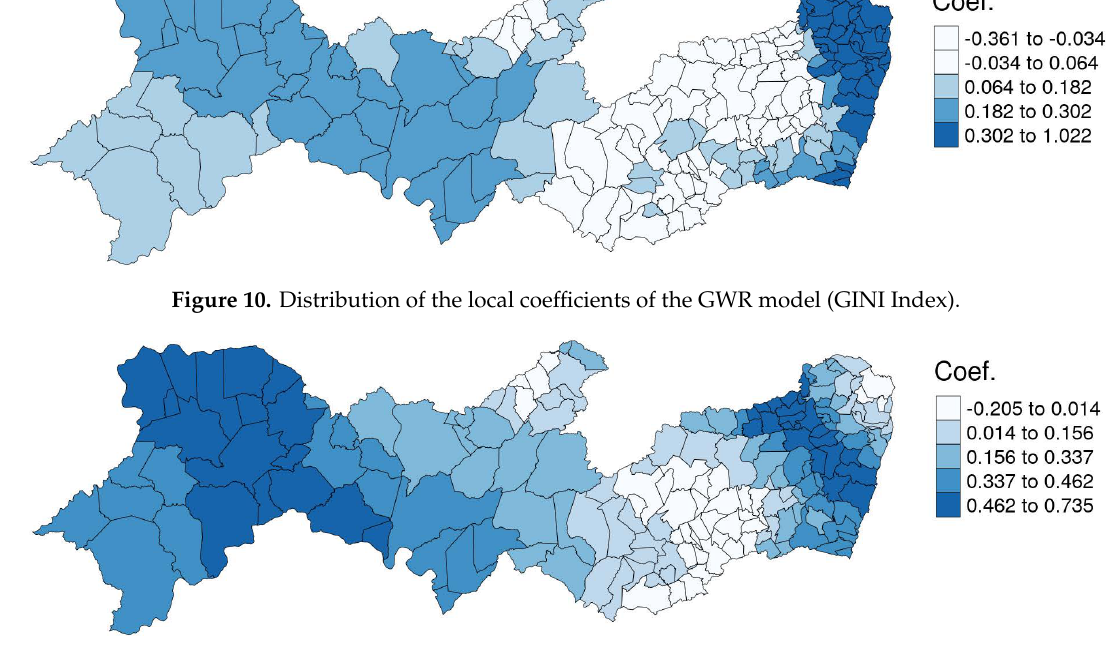
Figure 11. Distribution of the local coe ffi cients of the GWR model (Poverty